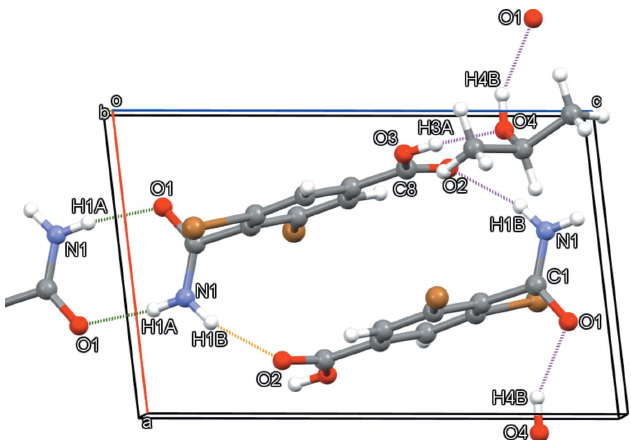
Figure 3 Hydrogen bonding in the crystal of (I), viewed along [010]. For clarity, the minor component and the lower-left molecule of 2-propanol are omitted from the unit cell. The dashed green lines represent amide dimerization. The dashed magenta lines represent the hydrogen bonds that form chains along [100]. The dashed orange line and its magenta counterpart (O2 (cid:2)(cid:2)(cid:2) N1) illustrate head-to-tail dimerization.